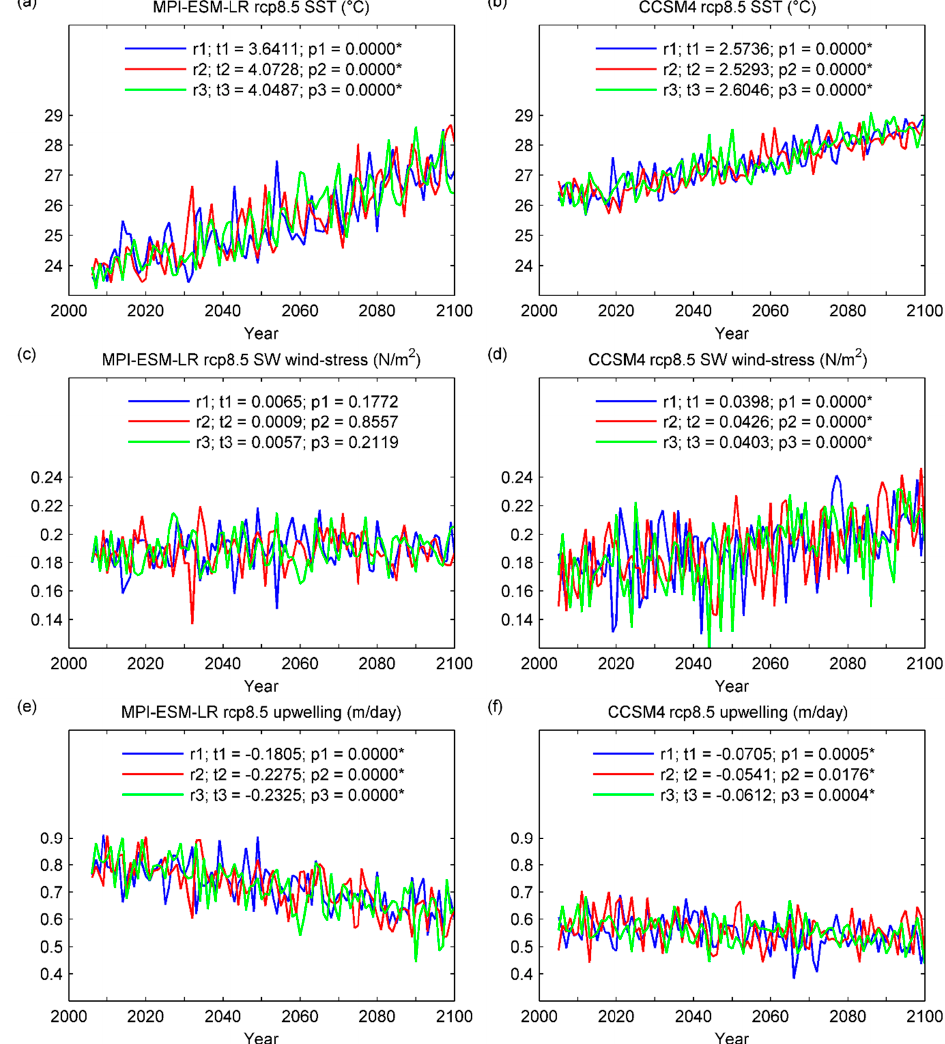
Figure 7. Time series of ( a ) SST, ( c ) SW wind-stress and ( e ) upwelling velocity modeled by MPI-ESM-LR under the scenario of RCP8.5 for the 21st century. ( b ), ( d ) and ( f ) are the same variables respectively modeled by CCSM4. r1, r2, r3 represent the three simulations of each model. t1, t2, t3 are the trends (per 100 years) of each simulation with p1, p2 and p3 indicating their p -values, respectively, and the star symbols mark the simulations that pass the significance test at the 95% level. All the simulations by the two models are quite consistent regarding the results for the RCP8.5 scenario by showing positive trends in SST and SW wind-stress but negative trends in upwelling velocity. The SST (Figure 7a,b) increases significantly under the effect of the greenhouse gas emission. In the MPI-ESM-LR model (Figure 7a) the SST begins with lower values than that in the CCSM4 model (Figure 7b) but they rise to similar values by the end of the simulations, so the SST modeled by the MPI-ESM-LR has a larger trend than the CCSM4. The SW wind-stress (Figure 7c,d) is also strengthened due to the enhanced contrast between the surface heating over the land and the sea. This finding of enhanced upwelling favorable winds is consistent with the result of Menon et al. [54]. They presented that the